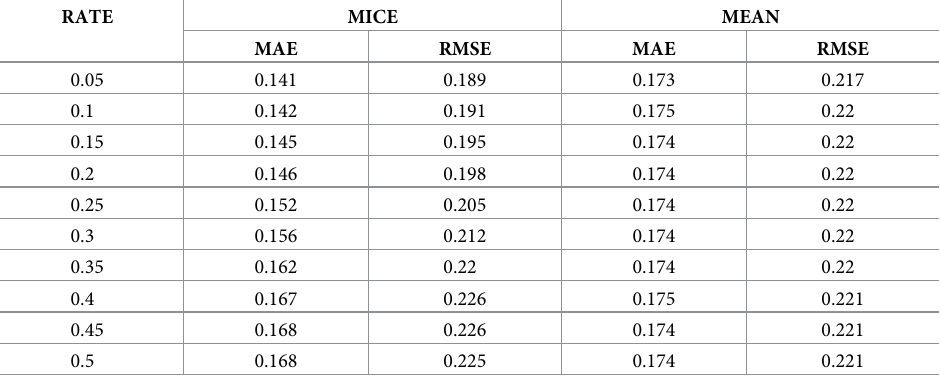
Table 5. The overall MAE and RMSE. RATE